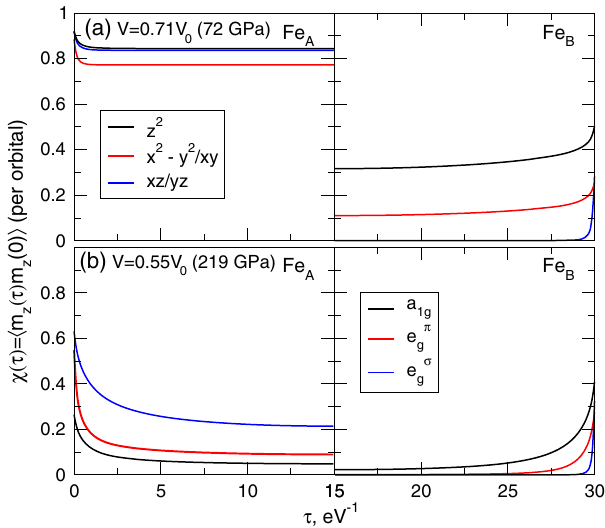
FIG. 5. Local spin-spin correlation function χ ð τ Þ ¼ h m ð τ Þ m ð 0 Þi calculated by DFT þ DMFT for paramagnetic z z DPv Fe 2 O 3